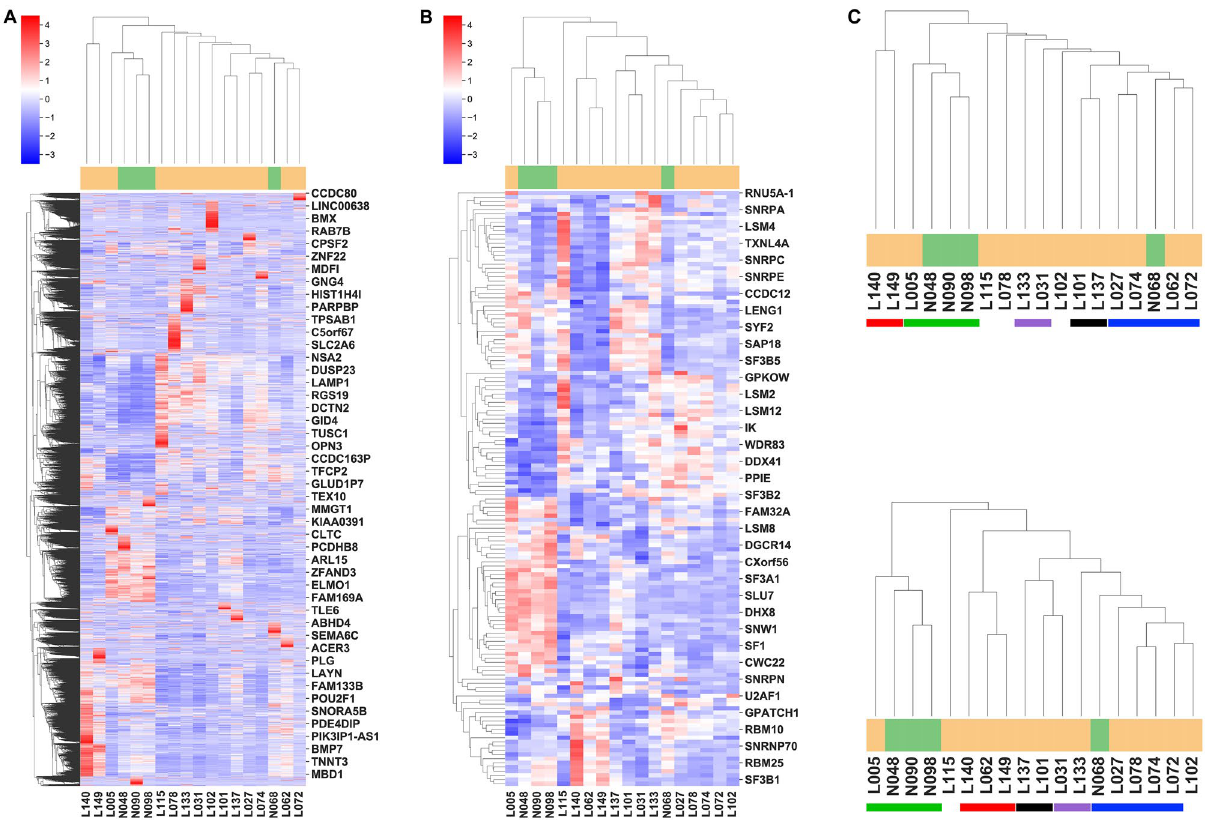
Figure 4. Gene expression profiles at both the genome level and the splicing factors level for T-cell samples. ( A ) Gene expression based hierarchical clustering of all genes in the whole transcriptome of all 18 T-cell samples including 4 normal controls and 14 SLE patients. Sample clustering is shown at the top with the sample label at the bottom. Gene clustering is shown to the left and ~ 50 marker genes distributed uniformly on the right side as location reference to gene clustering in Table S7. ( B ) Same clustering as in ( A ) but using 142 splicing factor genes (from HUGO Gene Nomenclature Committee Database) instead of the whole genome. About 40 marker genes on the right were distributed uniformly as location reference to splicing factor clustering in Table S8. ( C ) Similar clustering patterns of sample stratifications between the whole genome gene expression (top) and the splicing factor gene expression (bottom) were indicated by the color bars with the same color for the same